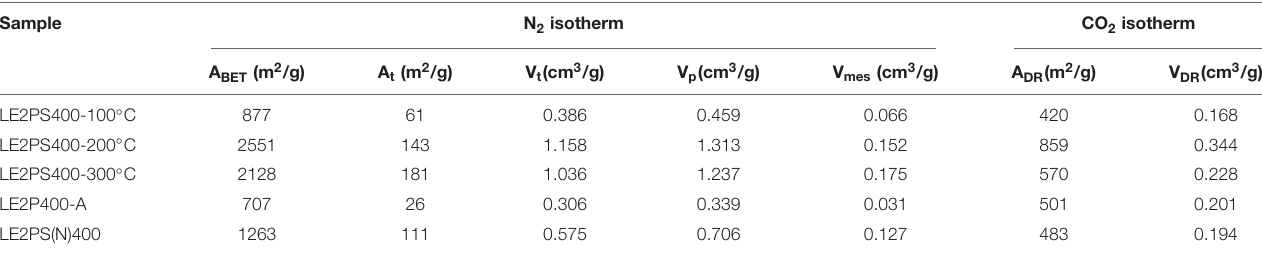
TABLE 5 | Textural properties of the different lignin activated carbons obtained at 400 ◦ C and H 3 PO 4 /lignin mass ratio of 2, treated at different temperatures under air atmosphere, obtained from the N 2 and CO 2 isotherms. Sample N 2